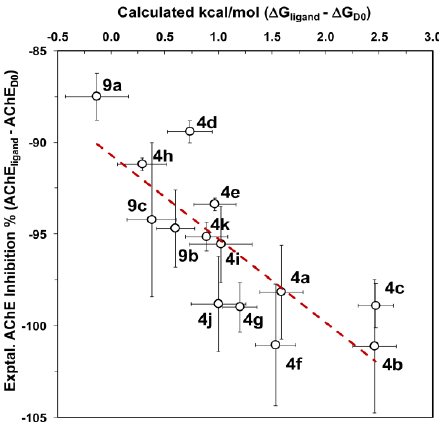
Figure 6. Free Energy vs. % AChE binding inhibition differences.